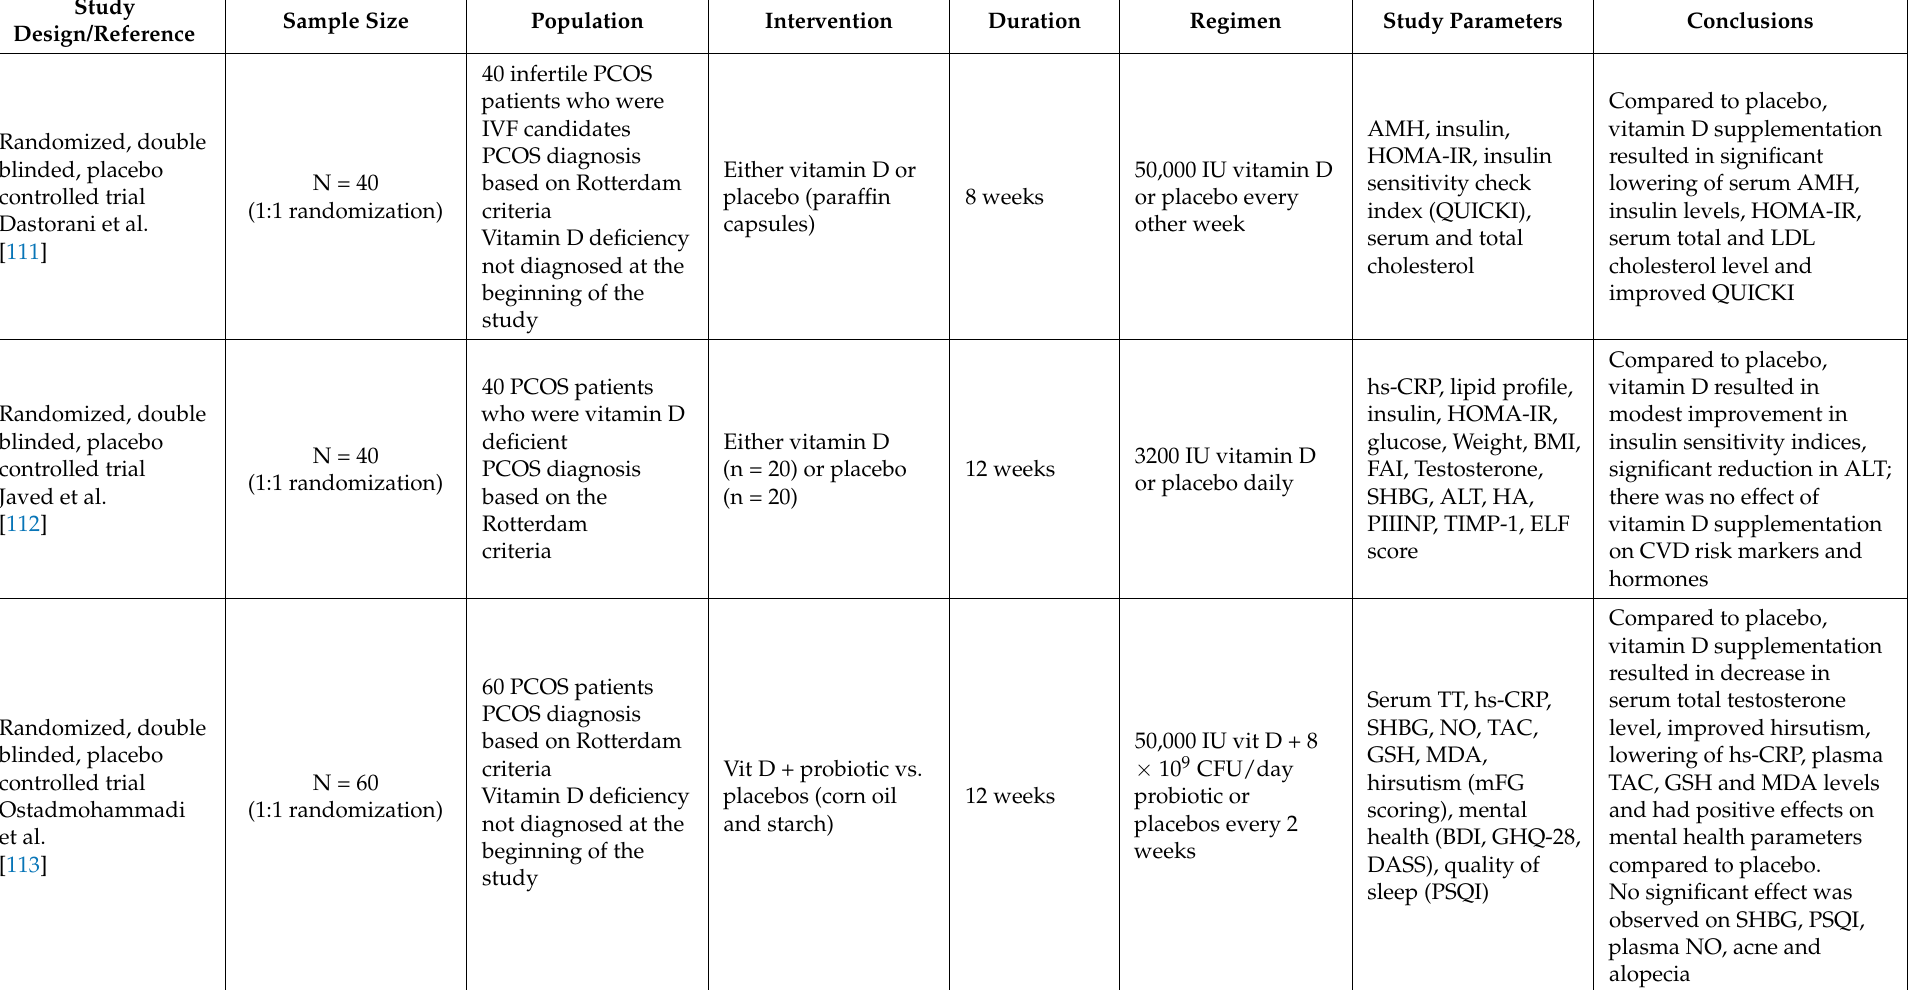
Table 2. RCT evidence on the effects of vitamin D supplementation on clinical and metabolic parameters pertinent to